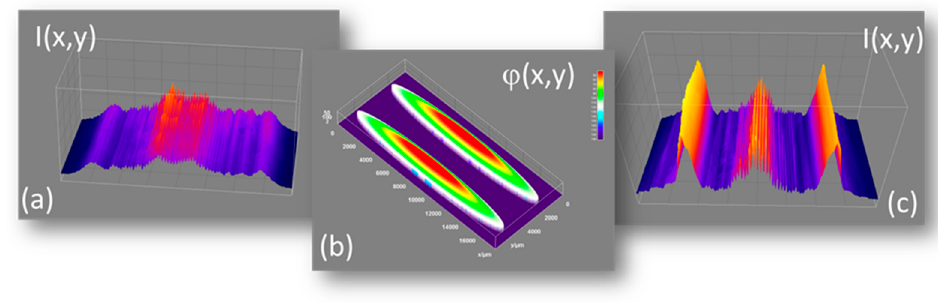
Figure 3. Structured illumination in configuration Com 1 : a pair of elliptical cylinder axicons was programmed into the SLM phase map (center, b ) to illuminate both parts of a MEMS Fresnel bi-mirror (area of partial mirrors: 2.5 × 5 mm 2 ). The comparison of the distorted intensity profile at a distance close to the overlapping zone without (left, a ) and with pre-shaping (right, c ) shows a significant improvement of the beam quality and the effect of self-apodization, i.e., a reduced diffraction by generating minimum intensity at the mirror edges (distance 5 cm, diode laser emitting at 790 nm central wavelength, and field of view 4.4 × 4.4 mm 2 ).